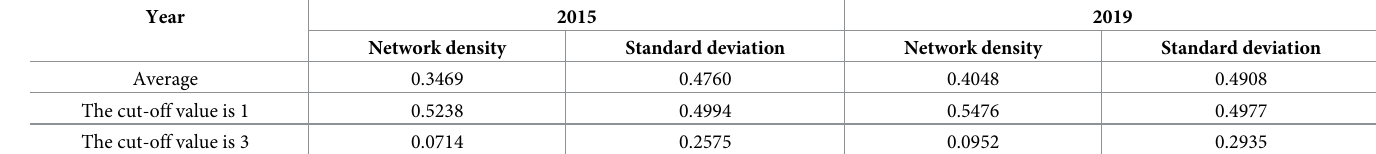
Table 1. Density of business credit linkage networks in the Hangzhou Bay Greater Bay Area, 2015 to 2019.